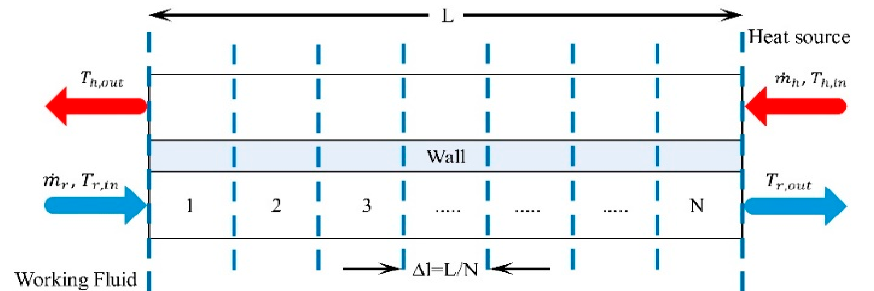
Figure 1. Discretisation of evaporator into N control volumes [27].